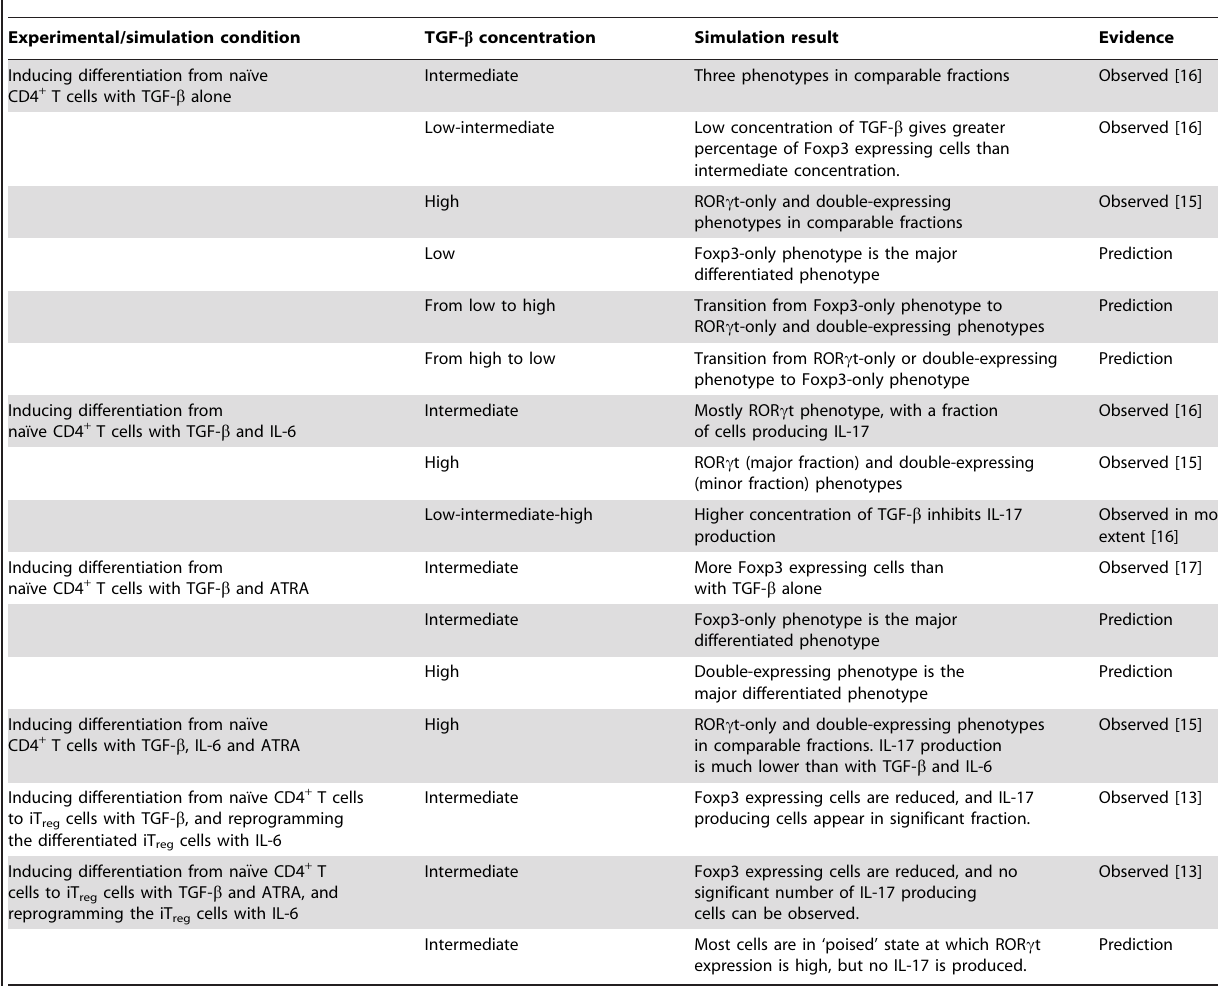
Table 2. Simulation results and comparisons with published experimental